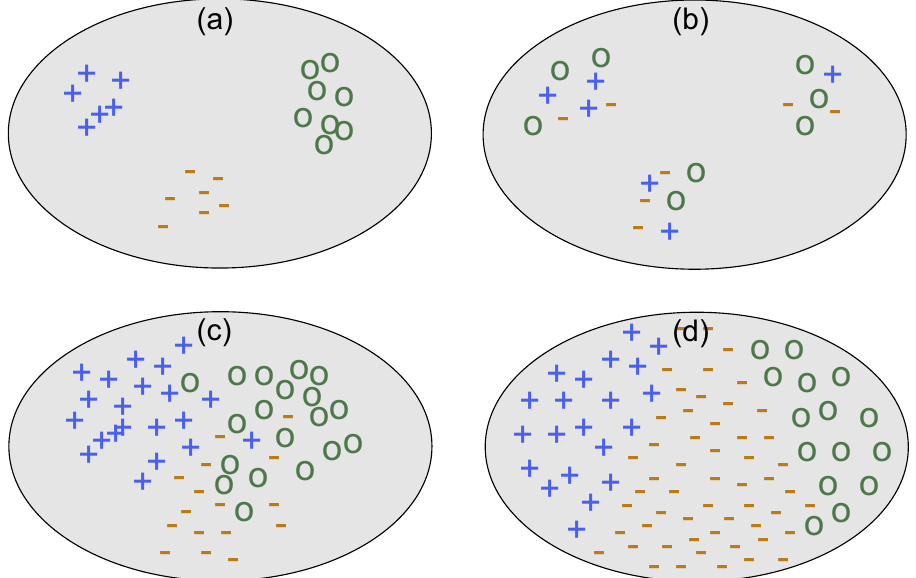
Figure 1. Schematic illustration of possible relations between the structure of data distributions and user- defined classes. The gray areas represent continuous vector spaces and each symbol corresponds to a data point located at a specific location in this vector space. The three symbols ’+’, ’−’ and ’o’ signify the class to which each data point has been assigned. ( a ) Strongly clustered data distribution where classes reflect the clustering structure. ( b ) Strongly clustered data distribution where classes are independent from the clustering structure. ( c ) Weakly clustered data distribution. Classes reflect this distribution but overlap. ( d ) Almost homogeneous data distribution with arbitrarily defined